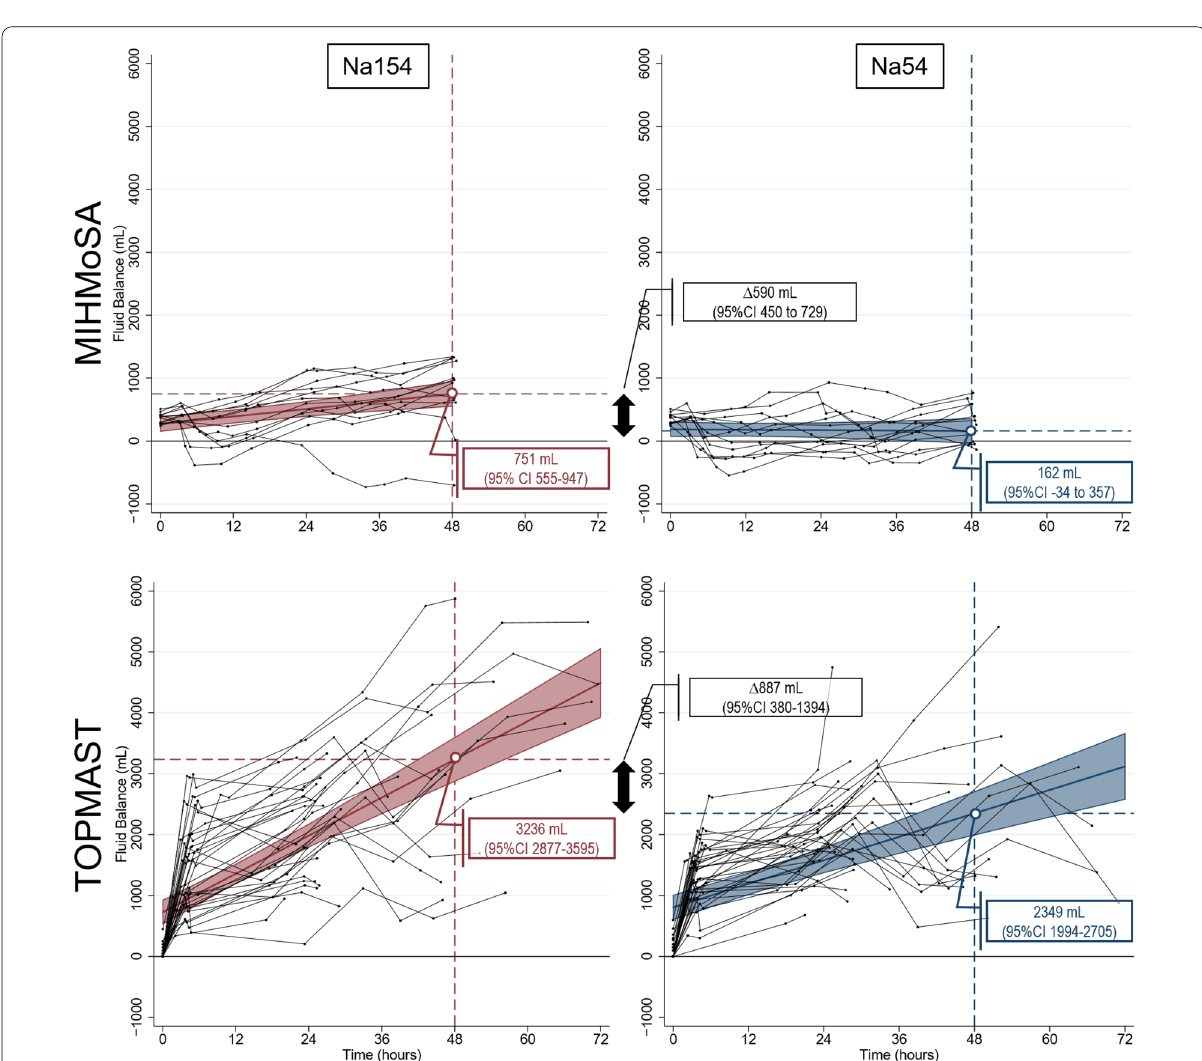
Fig. 1 Cumulative fluid balance of the MIHMoSA and TOPMAST trials. Both in healthy volunteers (MIHMoSA) and in patients undergoing major surgery (TOPMAST), fluid retention was significantly higher in the treatment arm receiving maintenance fluids containing 154 mmol/L of sodium (compared to 54 mmol/L). Compared to healthy subjects, the patient cohort had a more positive fluid balance, no matter the study fluid, partly due to other net fluid input ( 1.5 L) and partly due to the physiological response to hypovolemia, capillary leakage, etc. For details: see text. Adapted ± from Van Regenmortel et al. and Van Regenmortel et al., with permission [7,